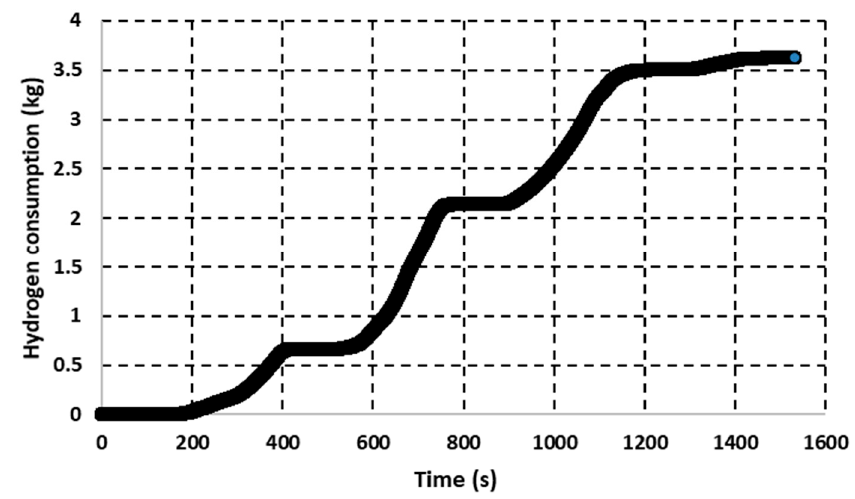
Figure 11. Hydrogen consumption for one trip.